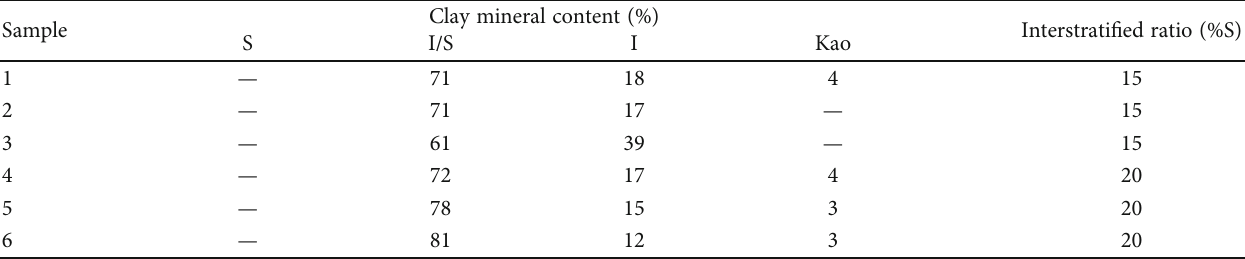
Table 2: Clay minerals relative